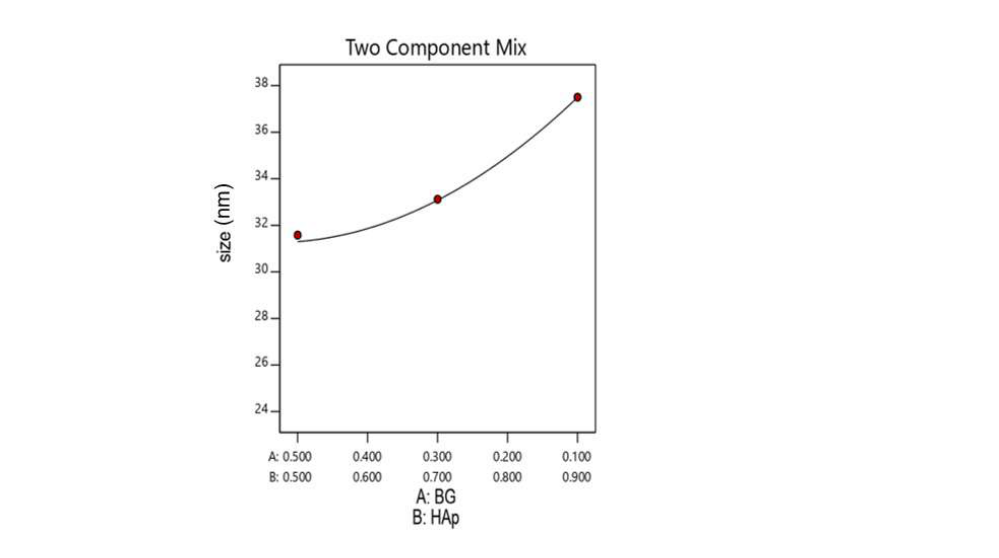
By studying the interaction of the two mixture components and the process temperature on the response of the model, 2D contour and 3D response level diagrams were plotted (Figure 7). These diagrams show that increasing component A (BG) from 10% to 50% decreases the crystal size of nanocomposites and suggest that HAp/BG ratio is a primary factor influencing composite crystal size. The same results have been found in a